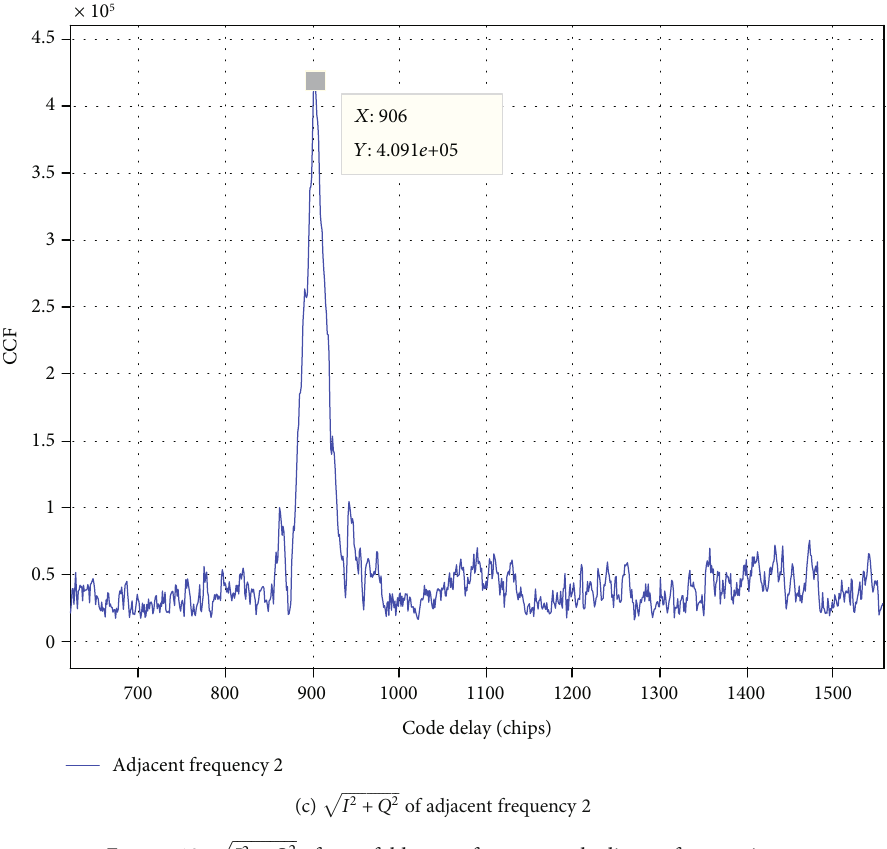
p ffiffiffiffiffiffiffiffiffiffiffiffiffiffi I 2 + Q 2 Figure 10: after enfoldment of correct and adjacent frequencies.